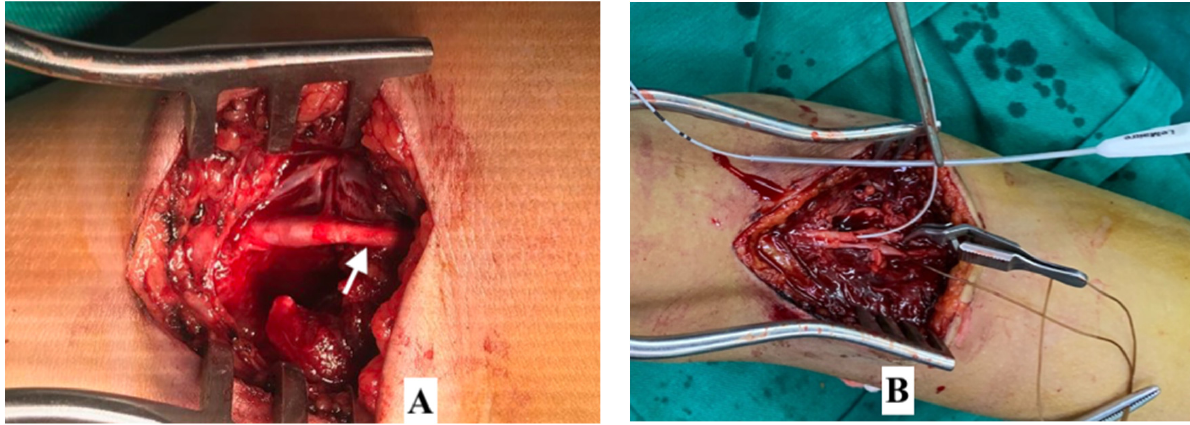
Figure 6. Vasospasm of brachial artery and its surgical management. ( A ) Vasospasm. ( B ) Balloon dilatation of the brachial ar-tery using the Fogarty catheter.